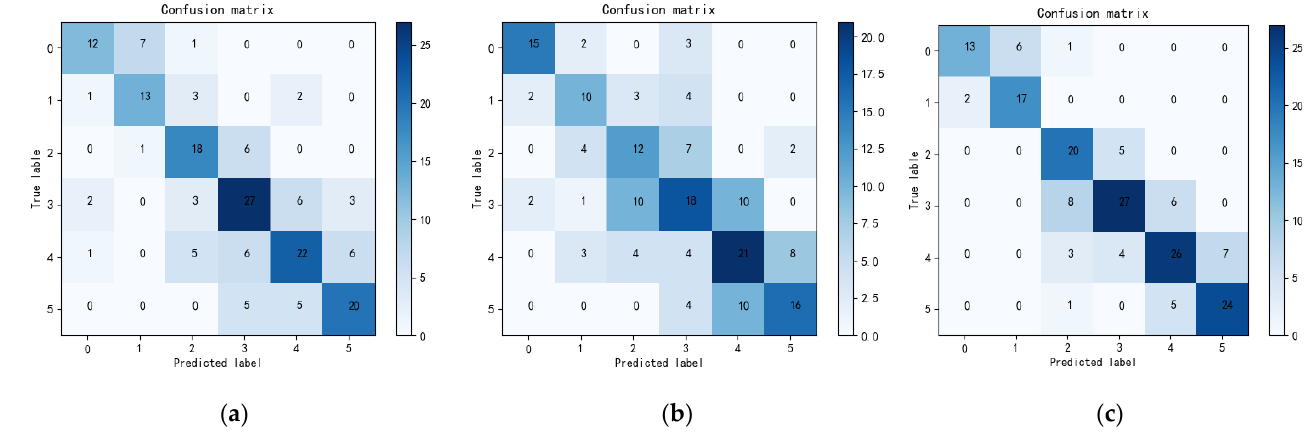
Figure 6. Confusion matrix. ( a ) M 1 module classification effect. ( b ) M 2 module classification effect. ( c ) The classification effect of the method in this paper.